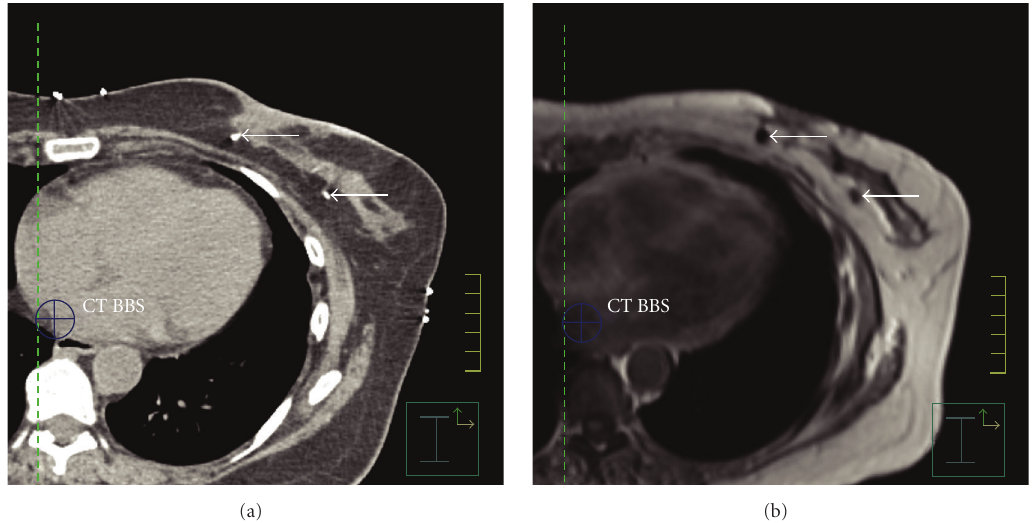
Figure 2: (a) Biopsy clips visible on CT. (b) Biopsy clips seen as signal void on T1